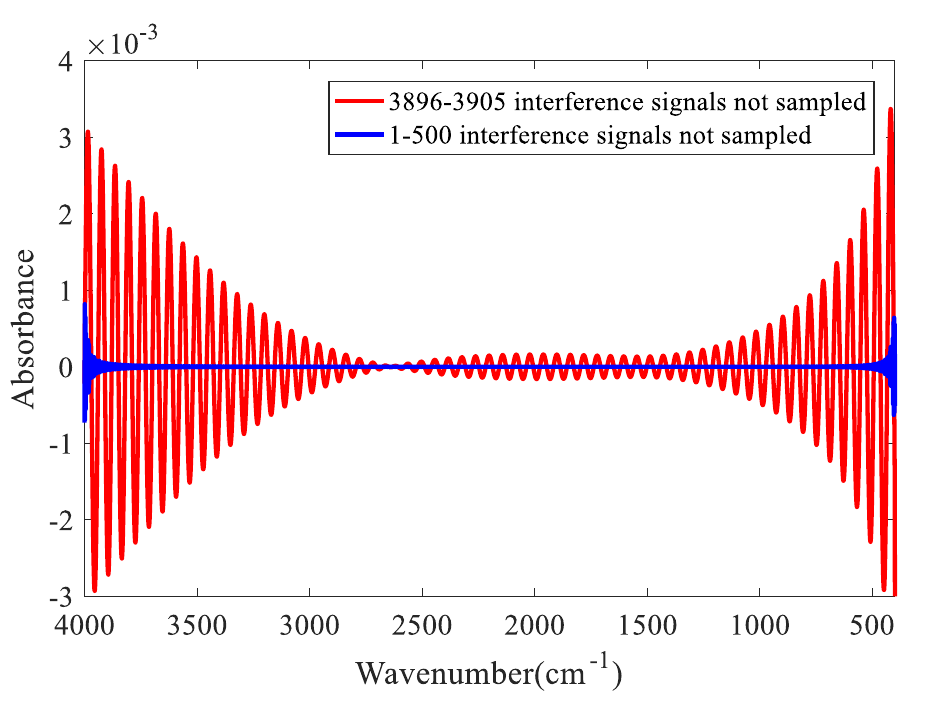
Figure 9. Influence of missing interference signal sampling on the baseline.